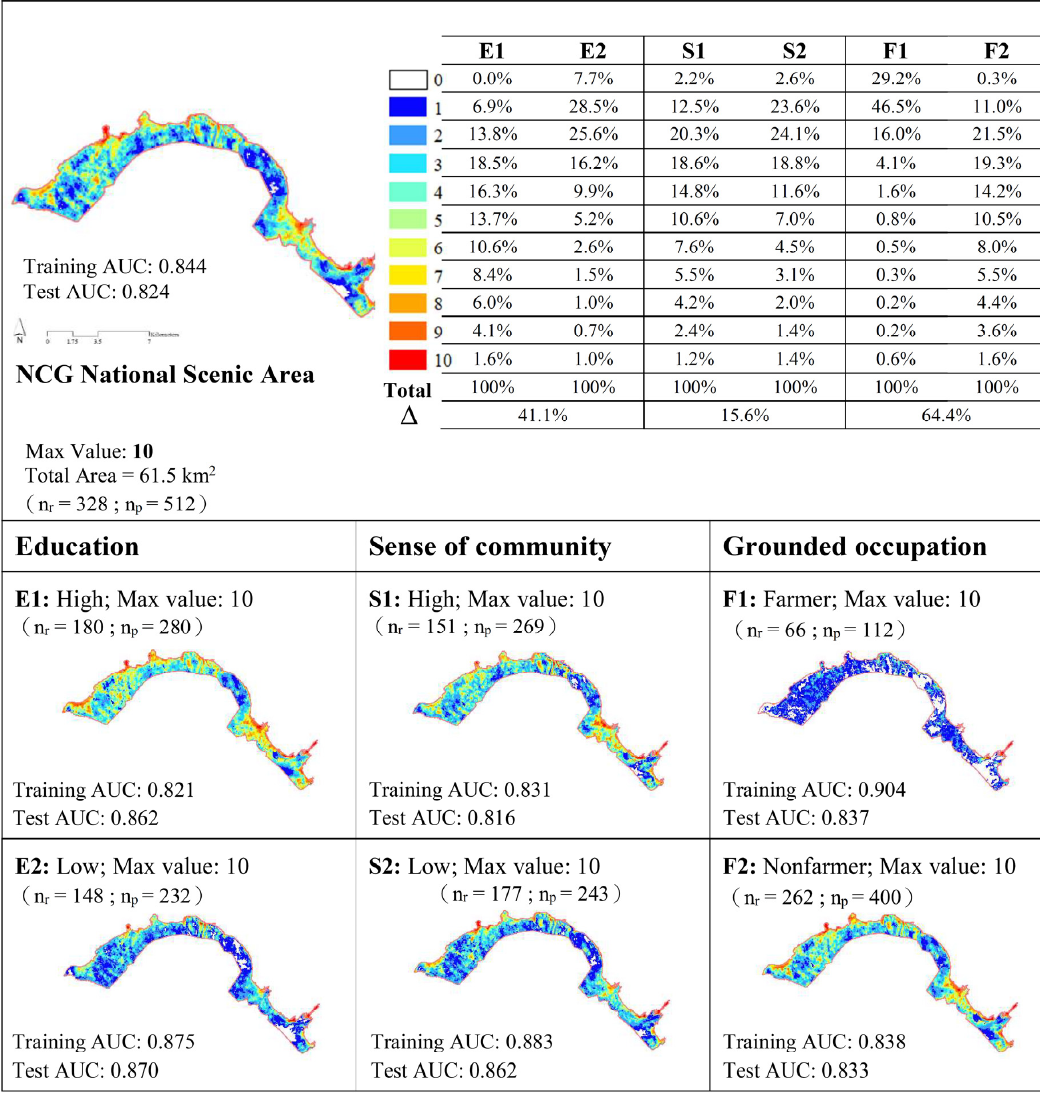
Figure 4. Recreation values between pair assumptions. Note: AUC: area under the curve; %: percentage of total area; Δ : index of dissimilarity; n r : number of respondents; n p : number of identified points; E1: high educational attainment; E2: low educational attainment; S1: high sense of community; S2: low sense of community; F1: farmer; and F2: nonfarmer.